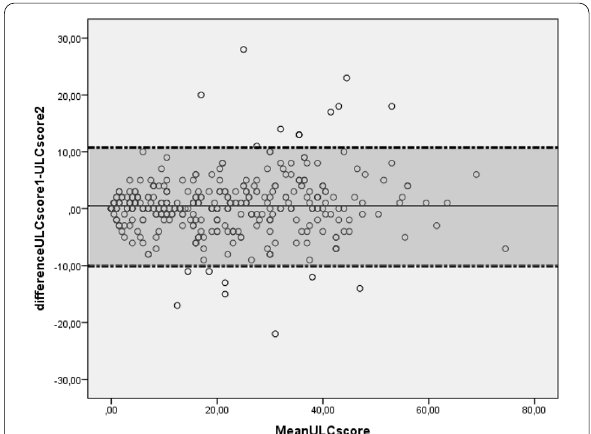
Fig. 6 Bland and Altman plot for ultrasound lung comets score. ULCscore1 denotes ultrasound lung comets score measured by the first operator; ULCscore2 denotes ultrasound Lung comets score measured by the second operator of the same pair of sonographers; shaded area denotes agreement